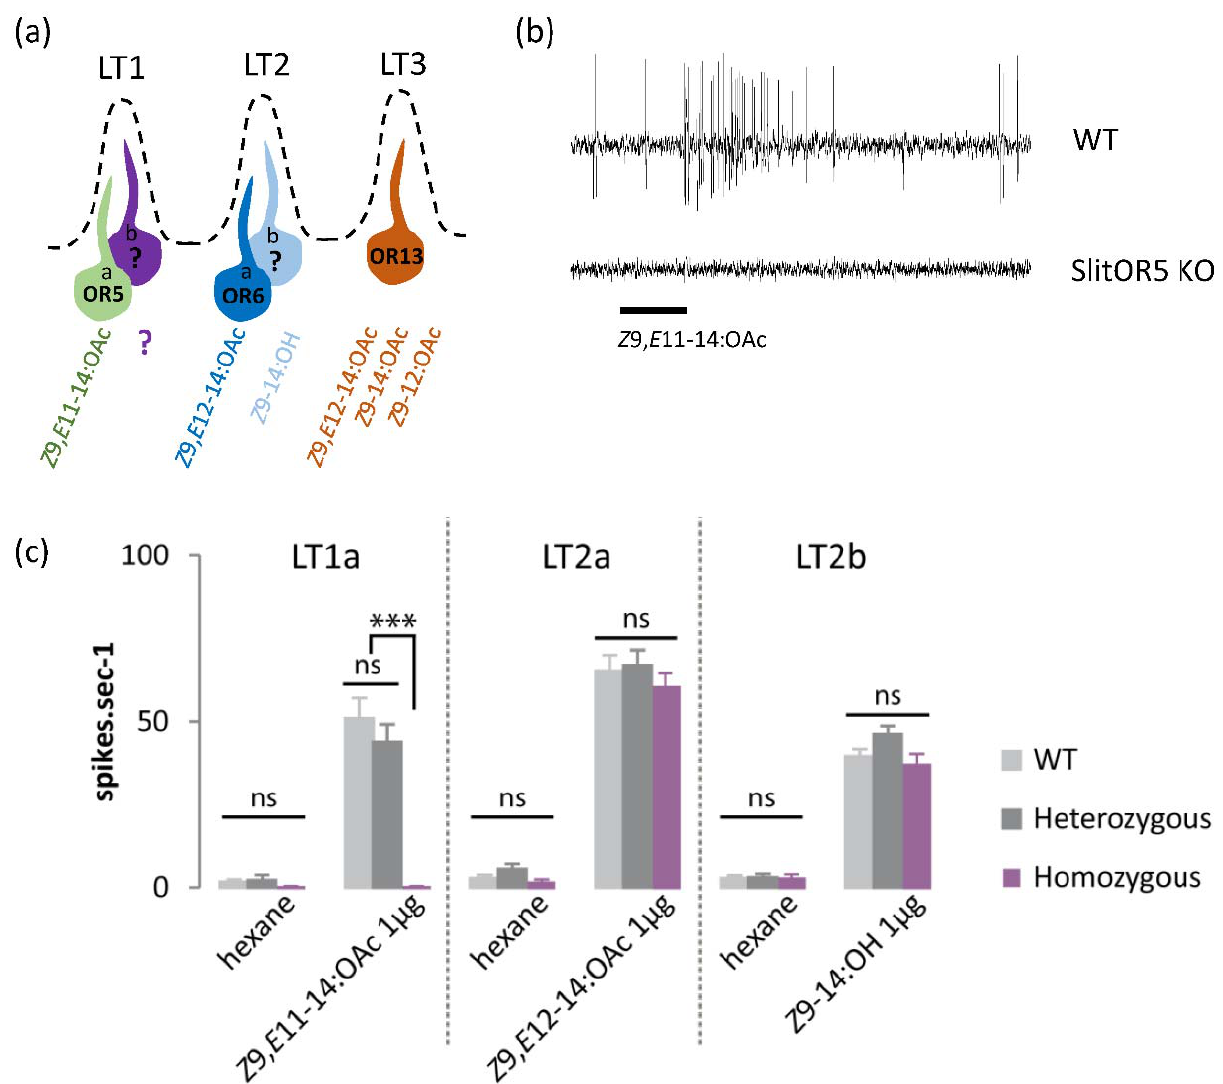
Figure 1. Effects of SlitOR5 knock-out on pheromone reception. ( a ) Diagram showing the different types of long trichoid (LT) sensilla found on S. littoralis male antennae, associated olfactory sensory neurons (OSNs a and b), and pheromone compounds detected when known (?: unknown). ( b ) Typical recording traces obtained from LT1a OSNs of wild type (WT) and SlitOR5 homozygous mutant males (KO) of Spodoptera littoralis when stimulated with Z 9, E 11-14:OAc. LT1a OSNs exhibited no spontaneous activity in SlitOR5 knock-out (KO) individuals, and the response to the major pheromone component was completely abolished. ( c ) Responses to pheromone components (1 µ g in the stimulus cartridge) of different pheromone sensitive OSNs (LT1a, LT2a, and LT2b) from wild type males (WT, light gray, n = 13), SlitOR5 heterozygous (dark gray, n = 12) and homozygous mutant (purple, n = 12) males. Responses are measured as action potential frequency (spike · s − 1 ) using SSR. Plotted values represent the mean response ± s.e.m (standard error of the mean). *** p < 0.001, significantly different from the response of the other genotypes; n.s.: not significantly different (one-way ANOVA, followed by a Tukey’s post hoc test).